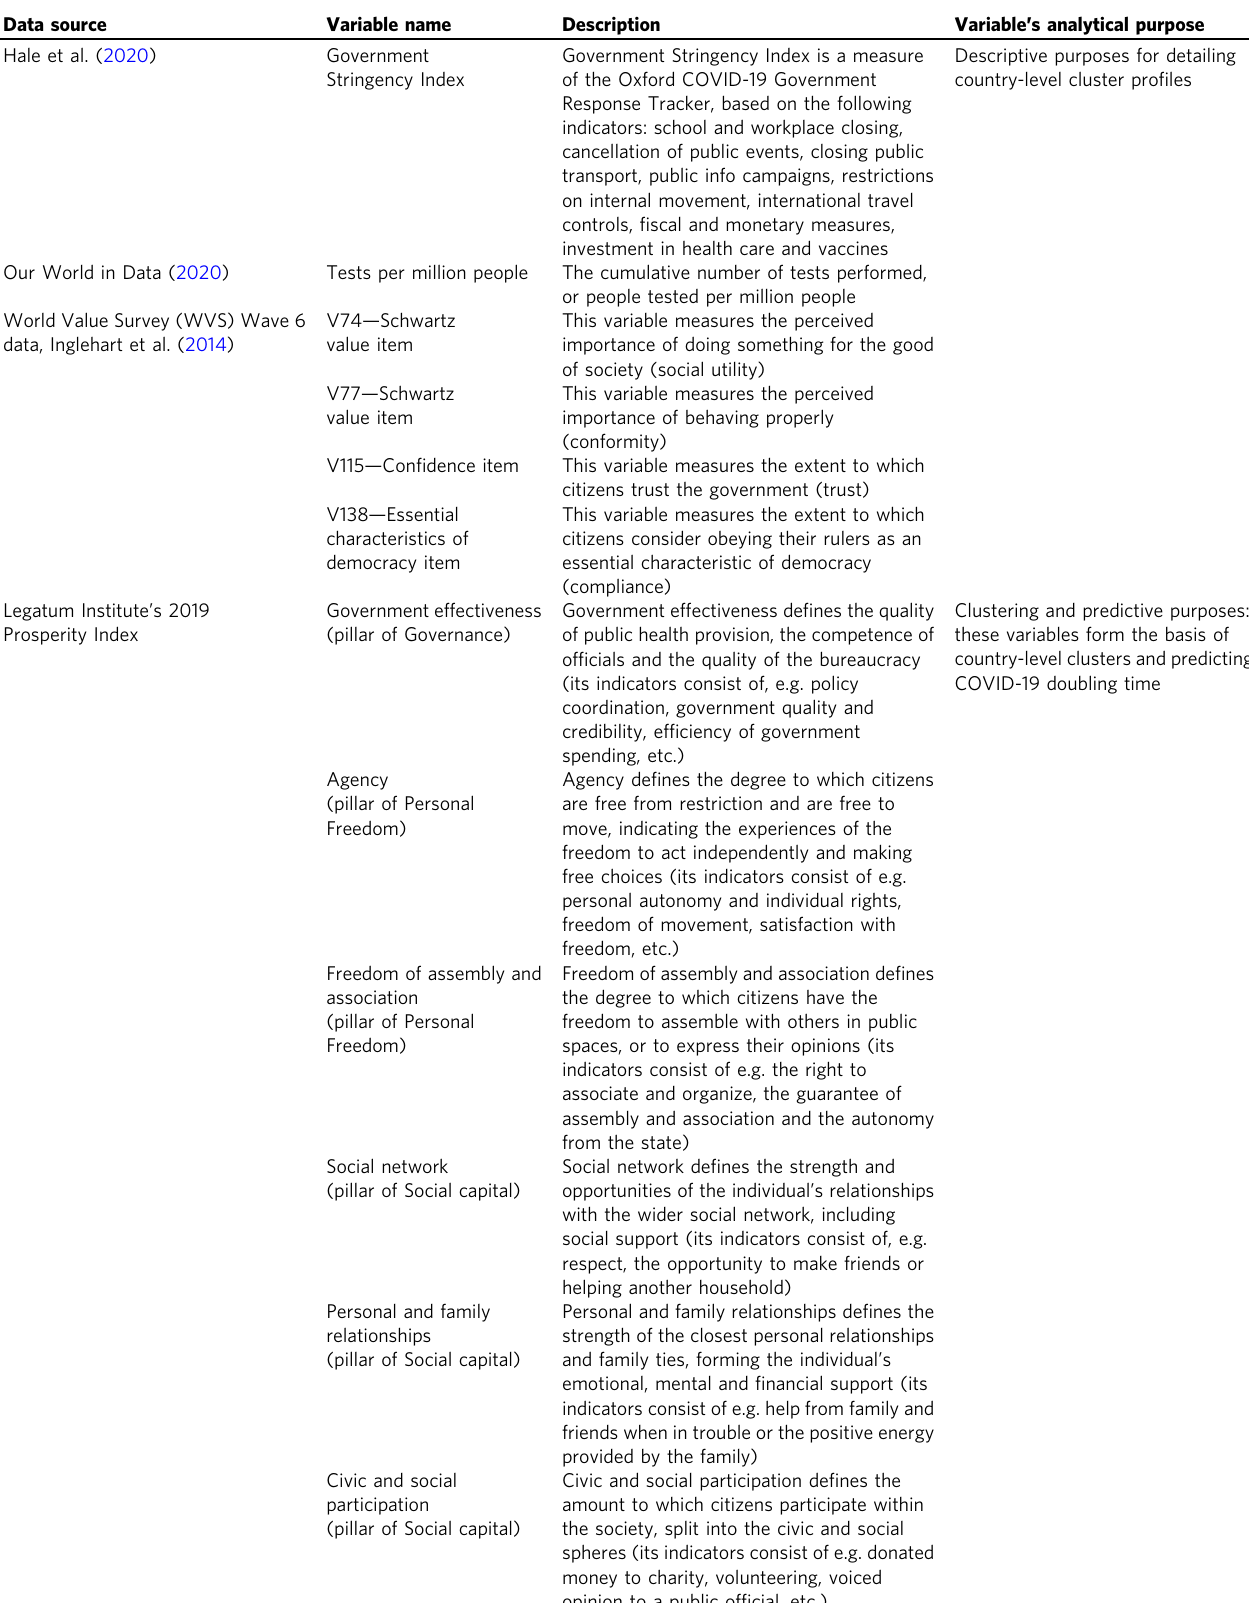
Table 1 Data sources, variable descriptions and variable ’ s purpose in the analytical